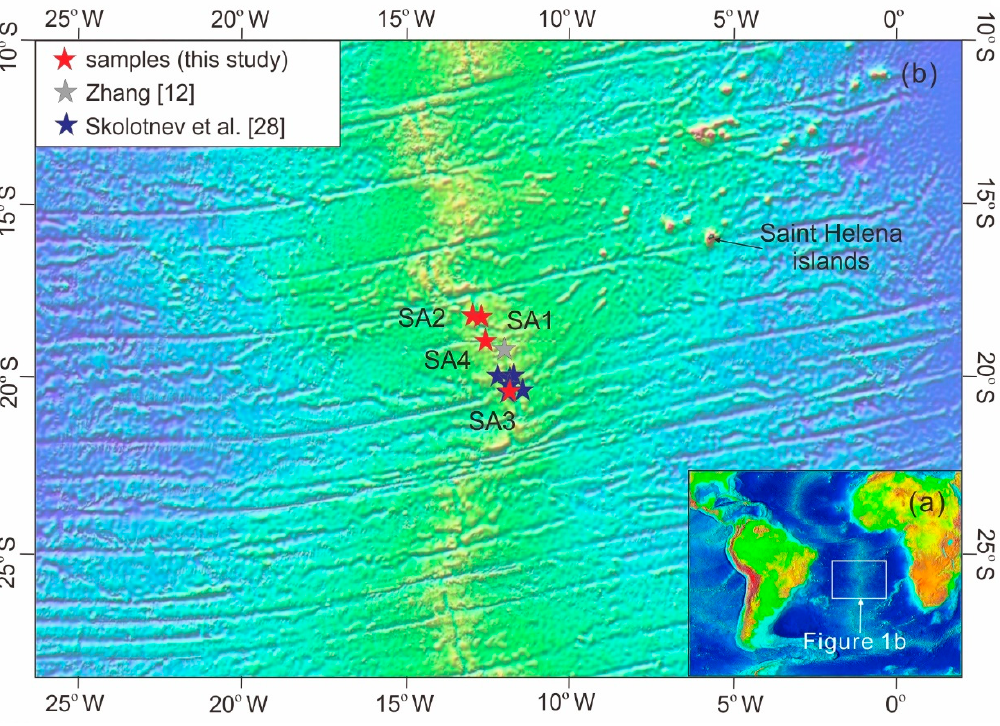
Figure 1. Map of the South Atlantic Mid-Ocean Ridge showing the locations of the dredged basalts analyzed in this study (map taken from [37]).